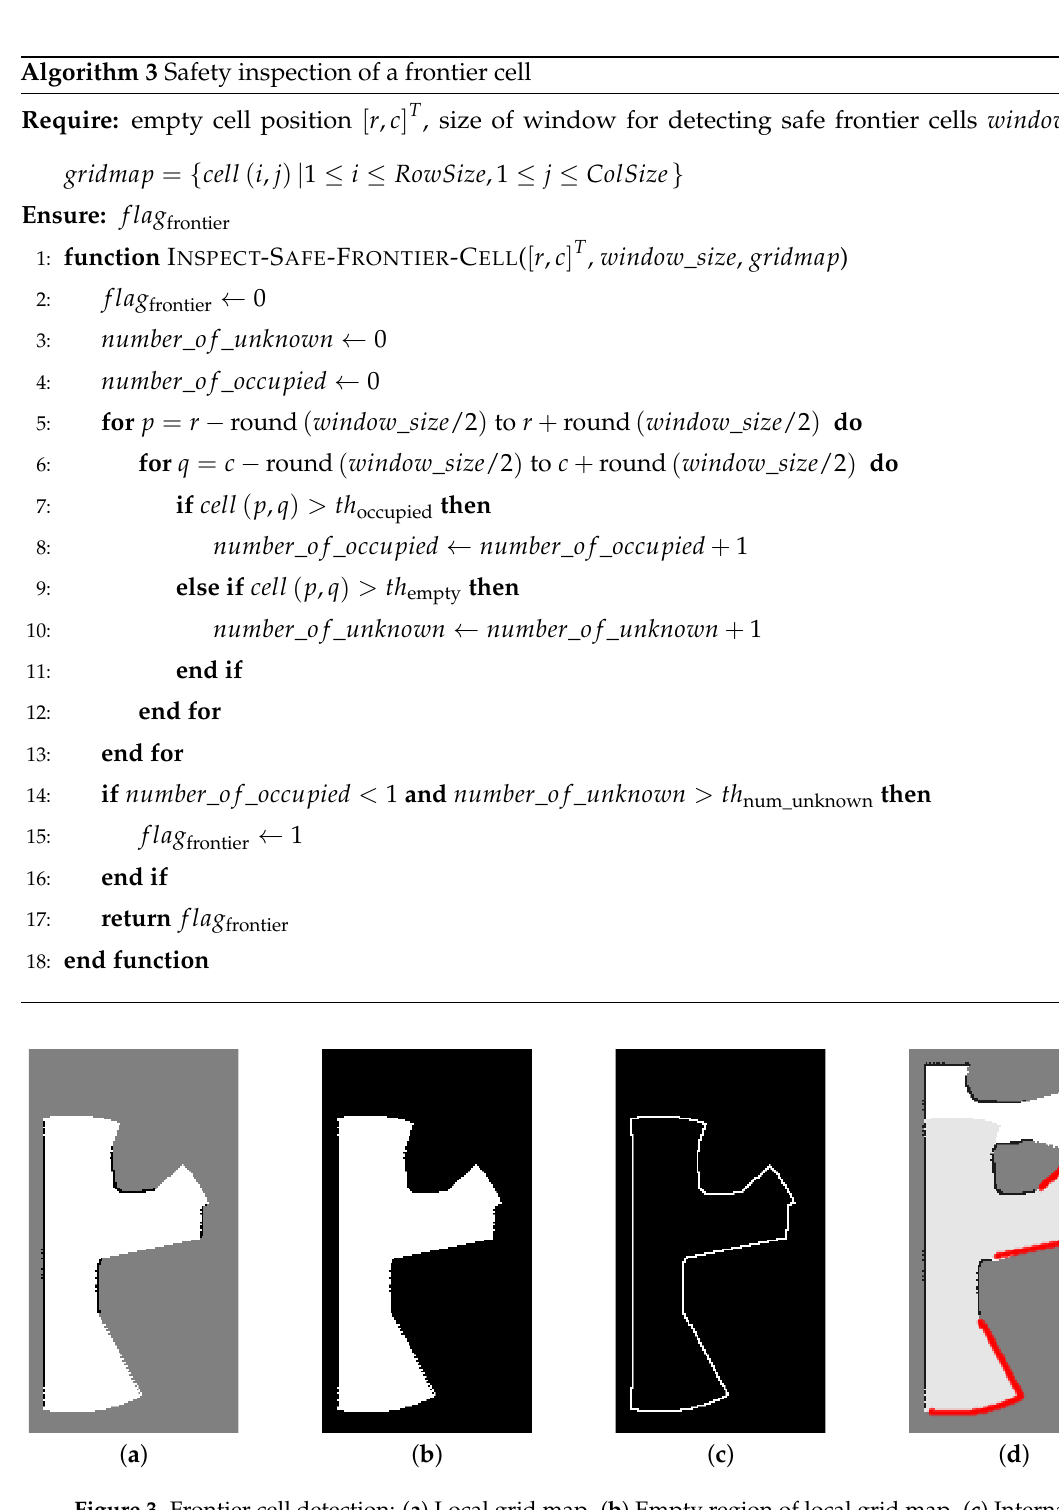
Figure 3. Frontier cell detection: ( a ) Local grid map. ( b ) Empty region of local grid map. ( c ) Internal boundary of empty region extracted by morphological operations. ( d ) Safe frontier cells (red stars) on merged